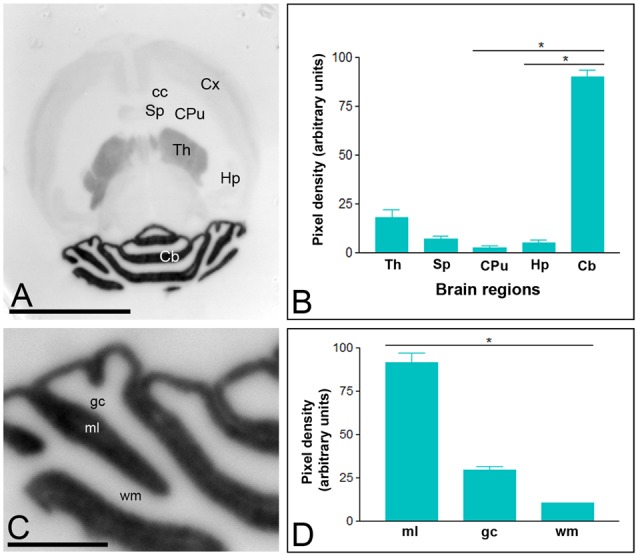
Regional distribution of the T-type Ca2+ channel Cav3.1 subtype in the adult mouse brain. (A–D) The distribution of the Cav3.1 protein was visualized in histoblots of horizontal brain sections at P90 using an affinity-purified anti-Cav3.1 antibody. Cav3.1 expression in different brain regions was determined by densitometric analysis of the scanned histoblots. The strongest expression was detected in the cerebellum (Cb) and thalamus (Th), with weaker expression in the septum (Sp), cortex (Cx) and hippocampus (Hp). The weakest expression level was detected in the caudate putamen (CPu). In the Cb, the strongest expression level was detected in the molecular layer (ml), with lowest intensity in the granule cell layer (gc) and white matter (wm). Error bars indicate SD; *P < 0.05. Scale bars: (A), 0.5 cm; (C), 0.1 cm.